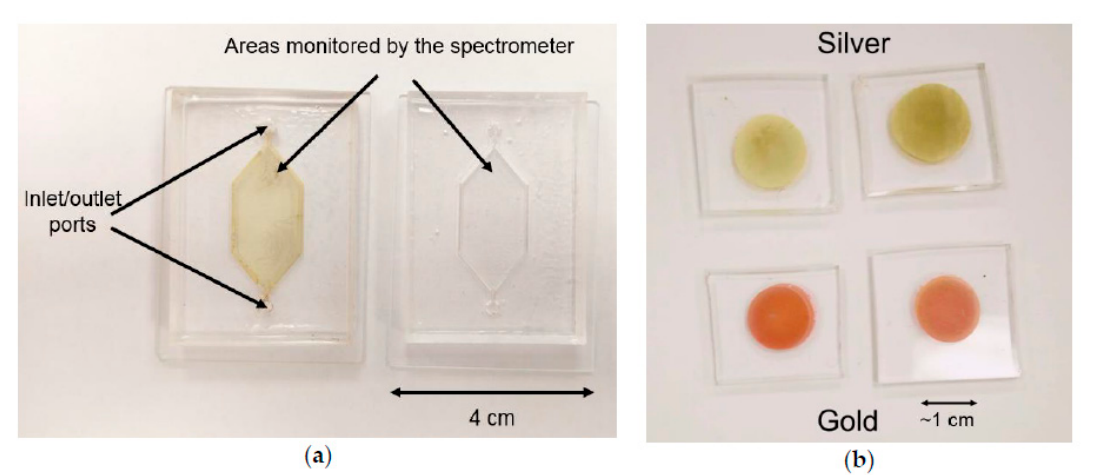
Figure 1. ( a ) The custom-designed PDMS microfluidic cell, which was used for the in situ monitoring of nanoparticle synthesis with optical spectroscopy Left: after a 2 days long silver nanoparticle synthesis; right: a freshly prepared cell. ( b ) PDMS-Ag (top row) and PDMS-Au (bottom